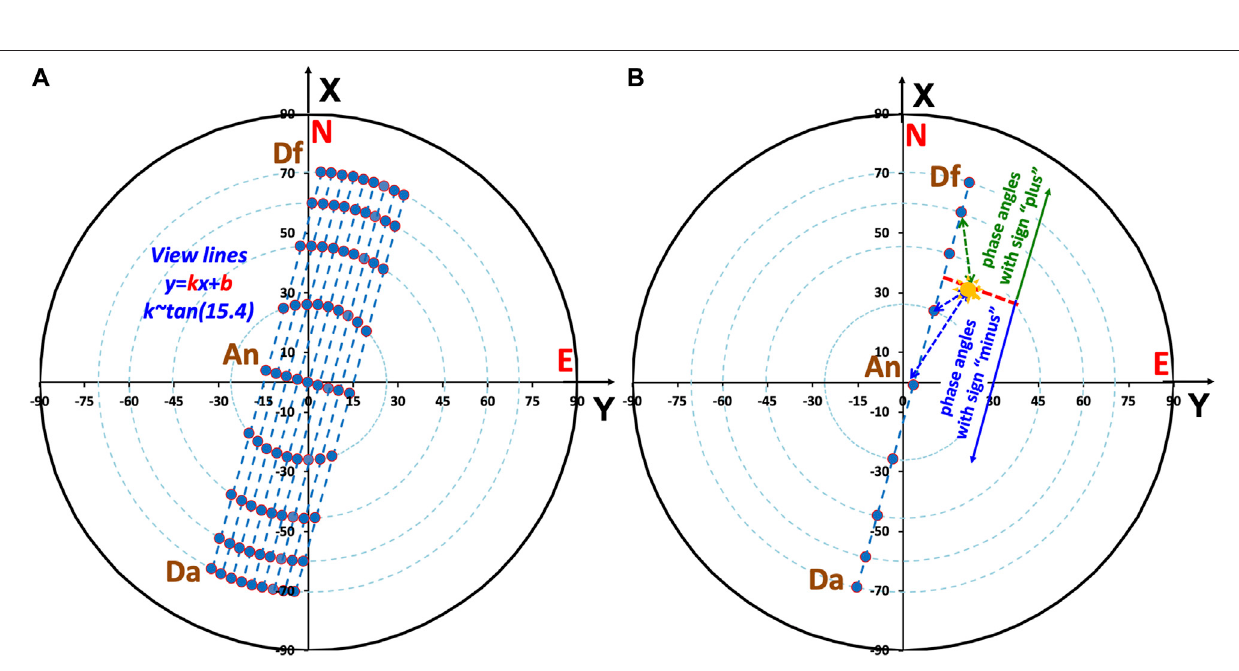
Frontiers in Remote Sensing |